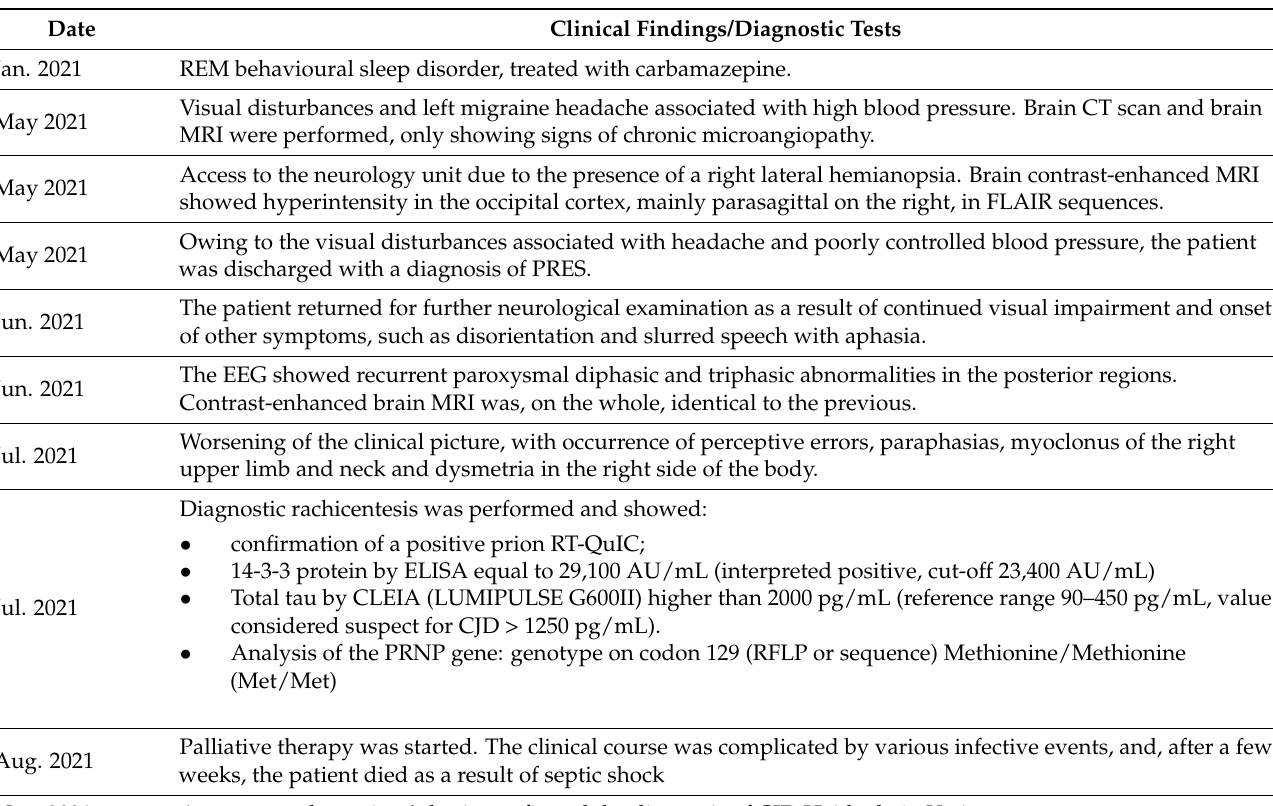
Table 1. Patient’s clinical